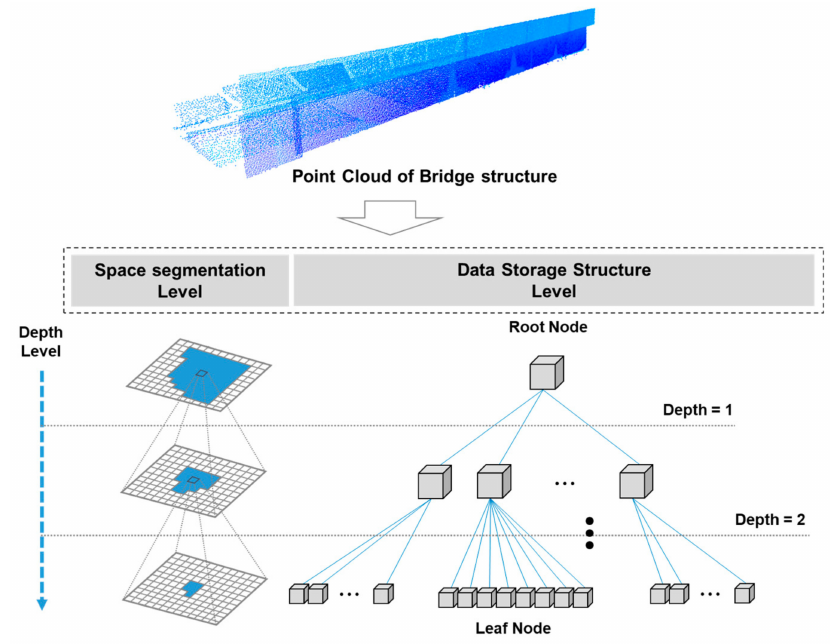
Figure 1. Storage structure of point cloud data based on octree space partitioning (OSP)